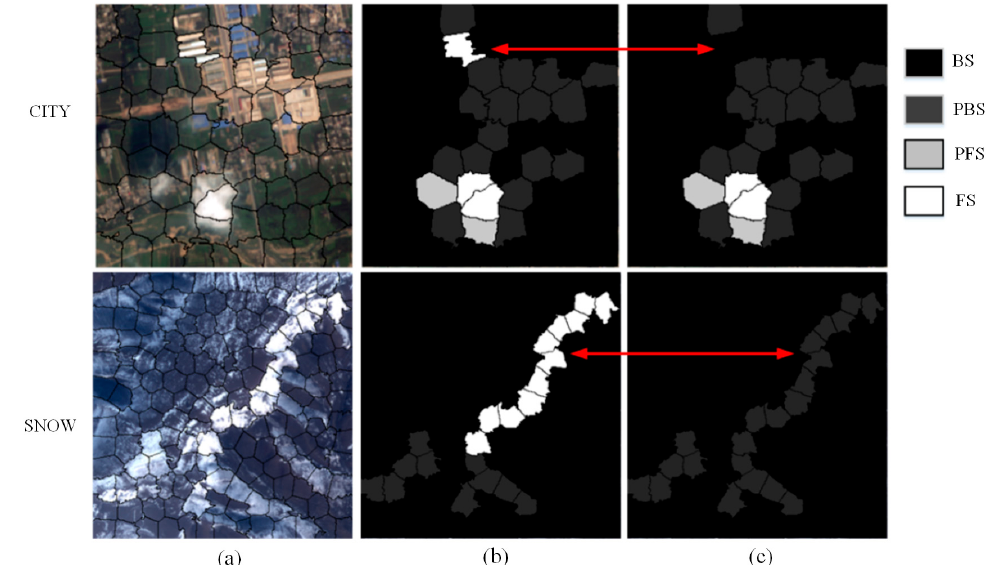
Figure 11. Example of cloud mask extraction using the proposed method. ( a ) Original image; ( b ) Cloud mask extracted by SVM. ( c ) Refined cloud mask. The white superpixles in ( b ) and ( c ) denote the foreground superpixels, the light gray ones denote possible foreground superpixels, the dark gray ones denote possible background superpixels, and the black ones denote the background superpixels. The red lines with double arrows between ( b ) and ( c ) point out the difference between before and after the refined cloud mask.